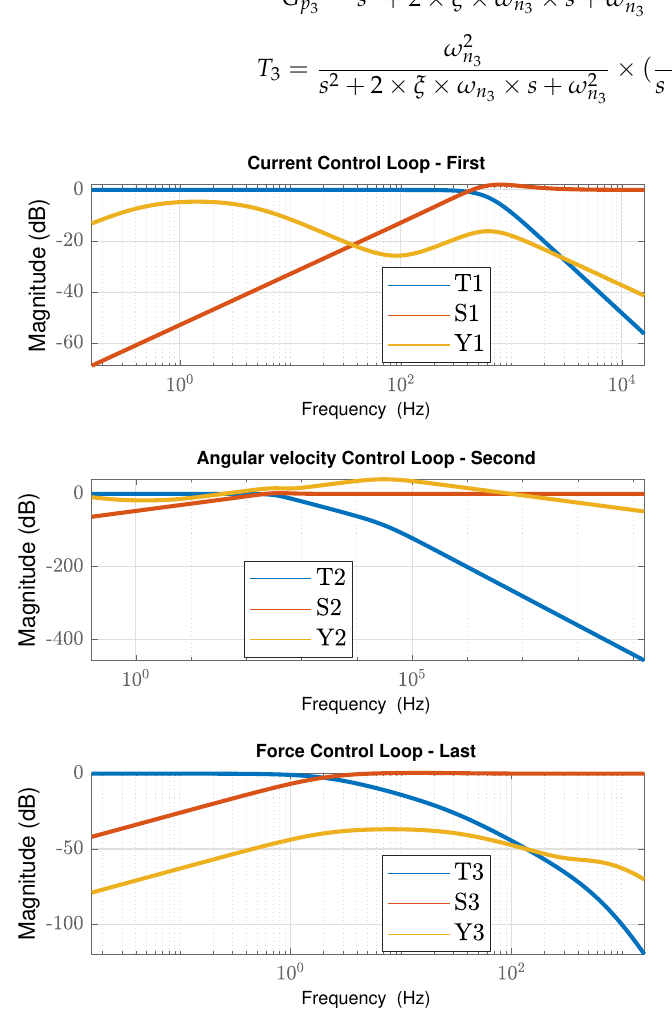
Figure 6. An example design of cascaded controllers for the